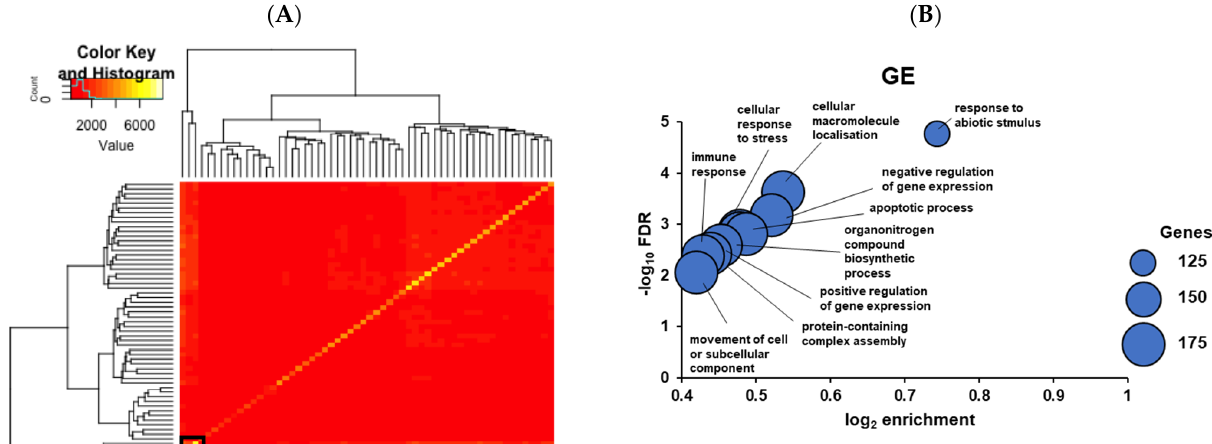
matching the GO term.